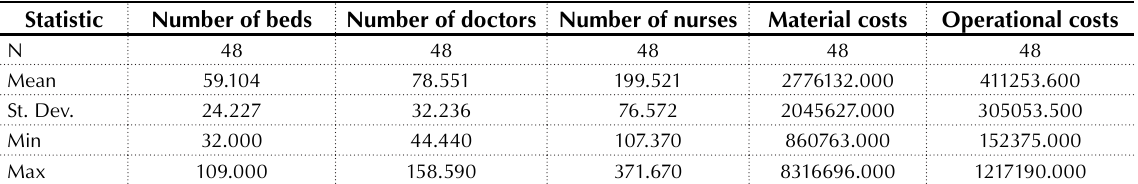
Table 1. Descriptive statistics of input variables